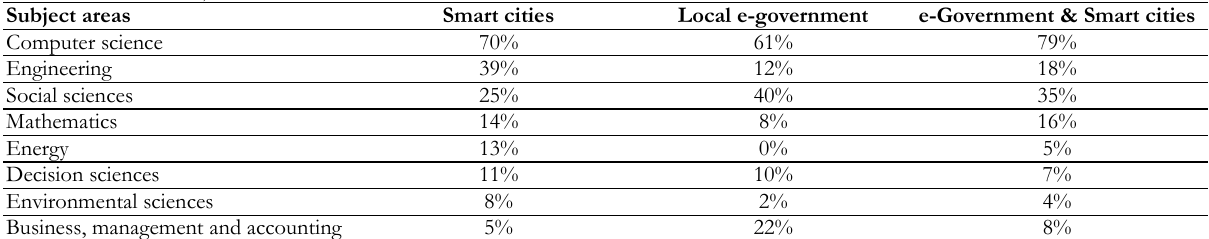
Figure 4. Evolution of the number of citations received by documents addressing smart cities in contexts other than e-government, published between 2009 and 2018, as retrieved from the Scopus database Table 2. Main subject